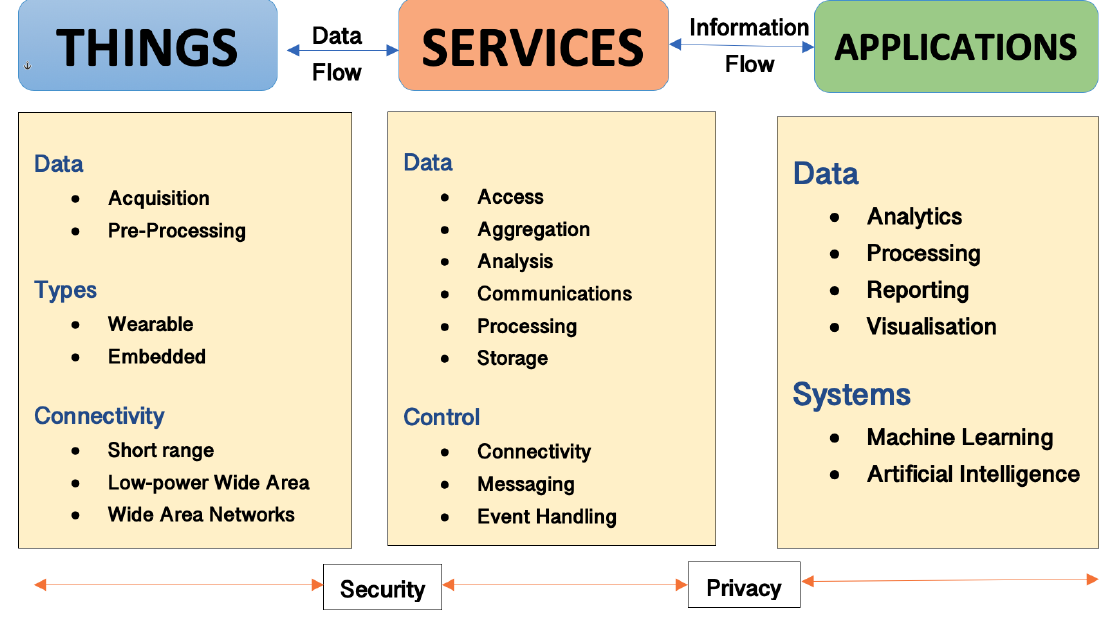
Figure 2. IoT’s operational